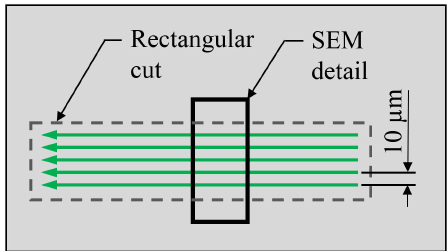
Figure 2. Scan pattern for the laser parameter tests. 5 parallel lines, each shifted for 10 µ m, were cut into the foil and yielded a rectangular cut as indicated by the dashed line. The position of the SEM details shown in Figures 3–5 is indicated.